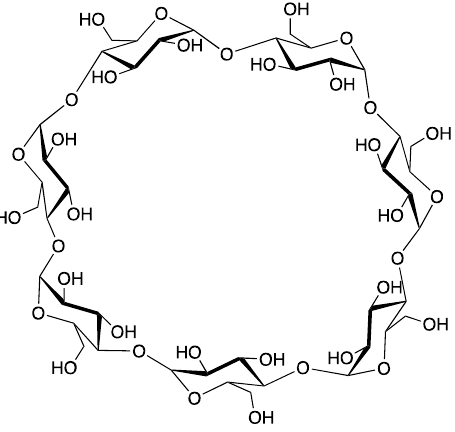
Figure 21. Molecular structure of β -cyclodextrin ( β -CD).